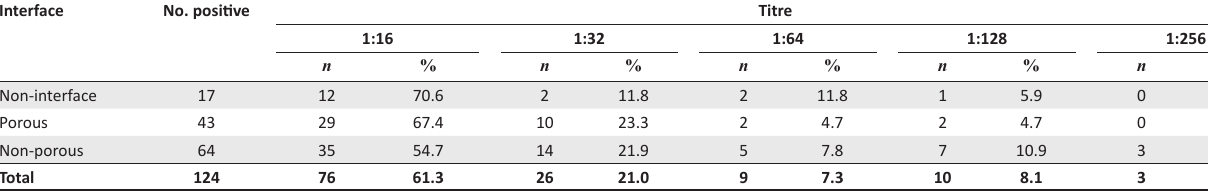
TABLE 3: Distribution of chlamydiosis seroprevalence according to interface and titre.